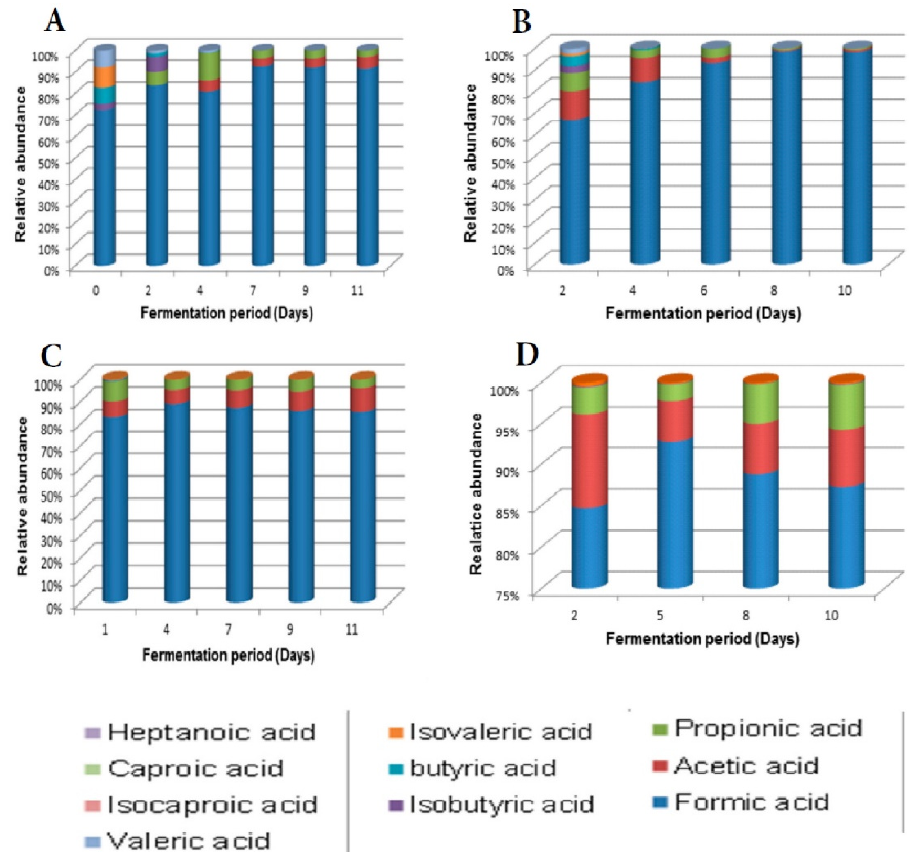
Figure 7. Volatile organic acids during fermentation of marula wine from ( A ) Lab, ( B ) Mentz, ( C ) Moshira-A and ( D )